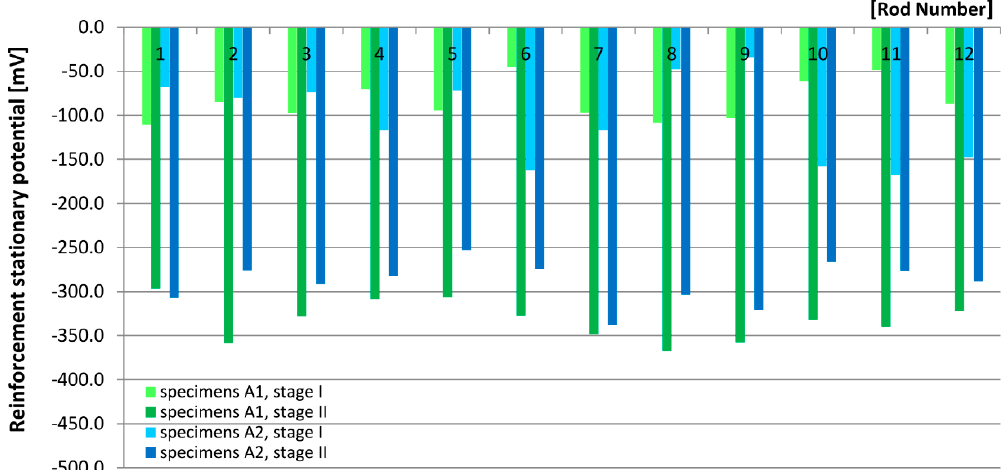
Figure 9. Results the measurements of the reinforcement stationary potential.